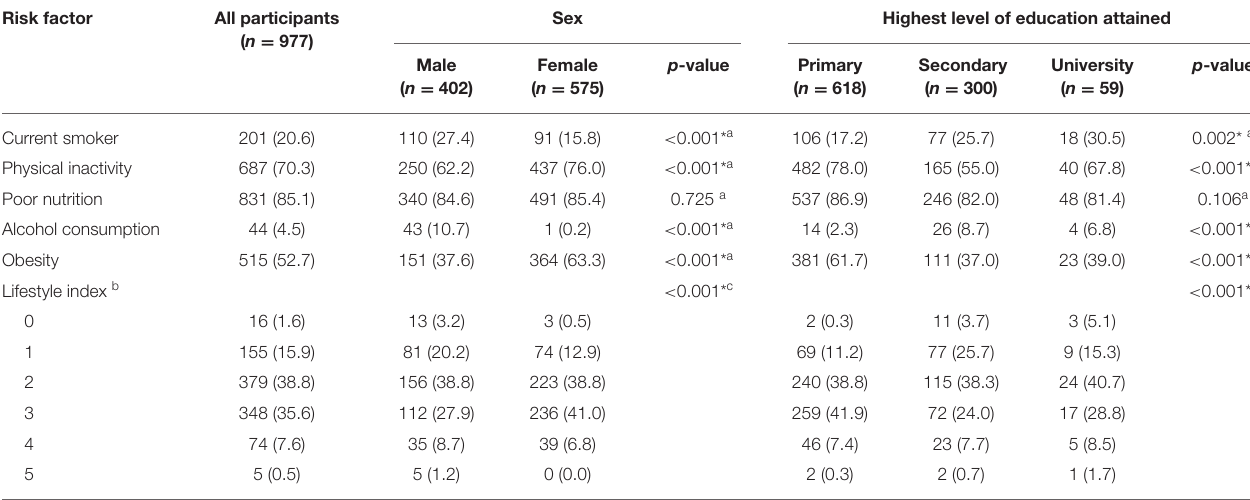
TABLE 2 | Prevalence of non-communicable disease risk factors, stratified by sex and highest level of education attained (Kosovo Non-Communicable Disease Cohort, Kosovo, 2019). Risk factor All participants ( n = 977)